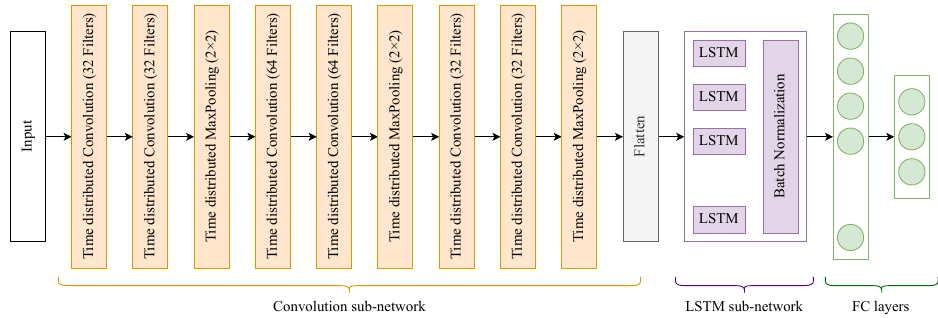
Figure 5. Architecture of the neural network used for classifying sequences generated by variations 2 and 3 of our classification